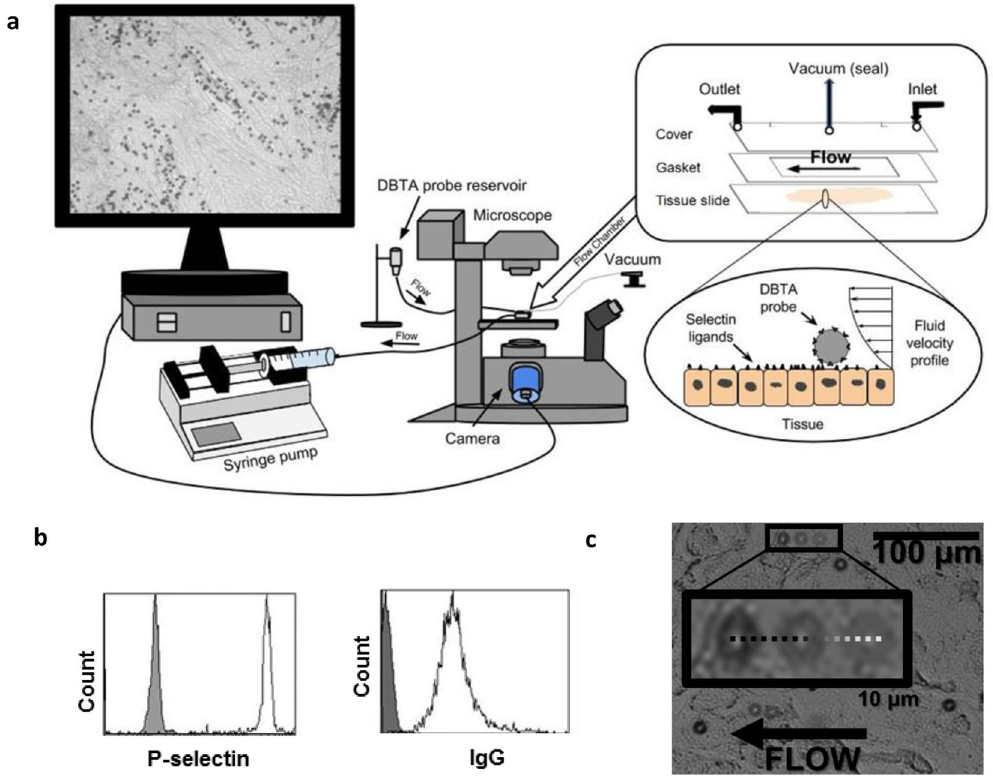
Figure 1. Introduction to the DBTA (dynamic biochemical tissue analysis) ( a ) DBTA probes (microspheres conjugated with a molecular probe such as a selectin or antibody) are perfused over tissue at defined wall shear stresses using a syringe pump and parallel plate flow chamber. Schematics are not to scale. ( b ) DBTA probe conjugation with the desired molecular probe (e.g., P-selectin or human IgG) can be verified with flow cytometry. ( c ) Images from three time points have been combined to show a sample P-selectin DBTA probe rolling on a colon carcinoma